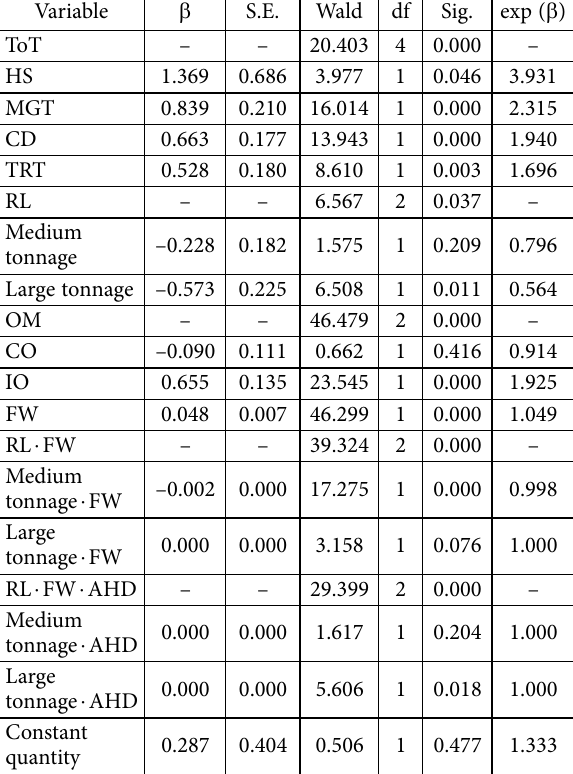
Table 4. Analysis results of BLR–CART model